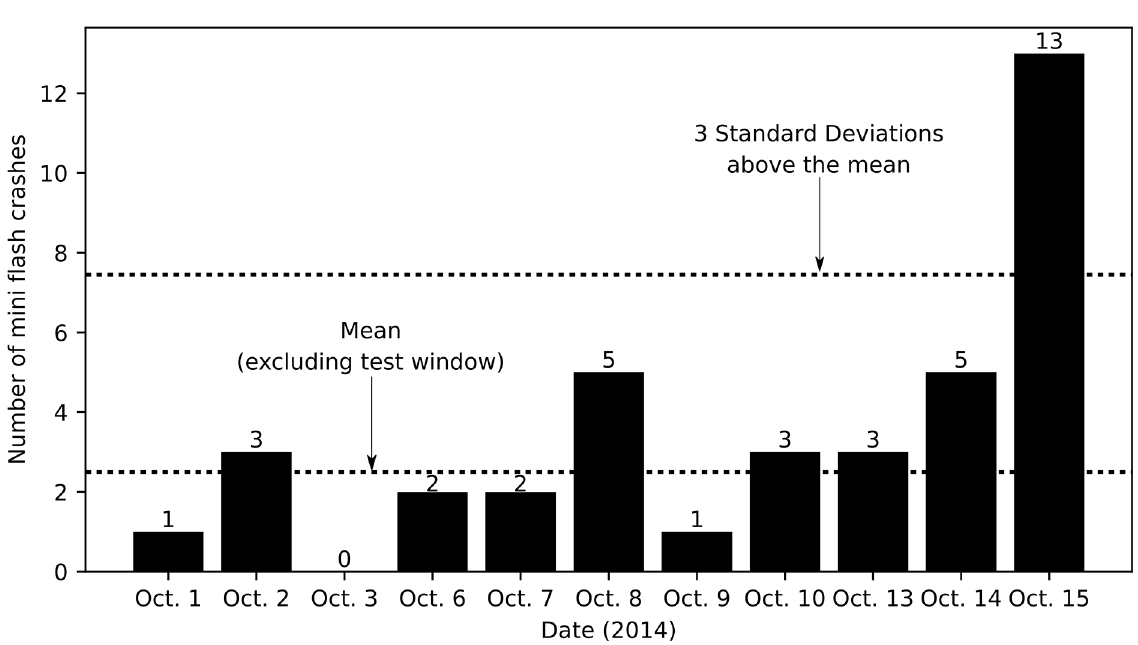
Fig 1. Number of mini flash crashesduring Control Period 1 (9:30–9:33 windows). The number of mini flash crashes during the test windowon Oct. 15 is 2.6 times greater than the greatest number of mini flash crashesexperiencedduringany other 9:30– 9:33